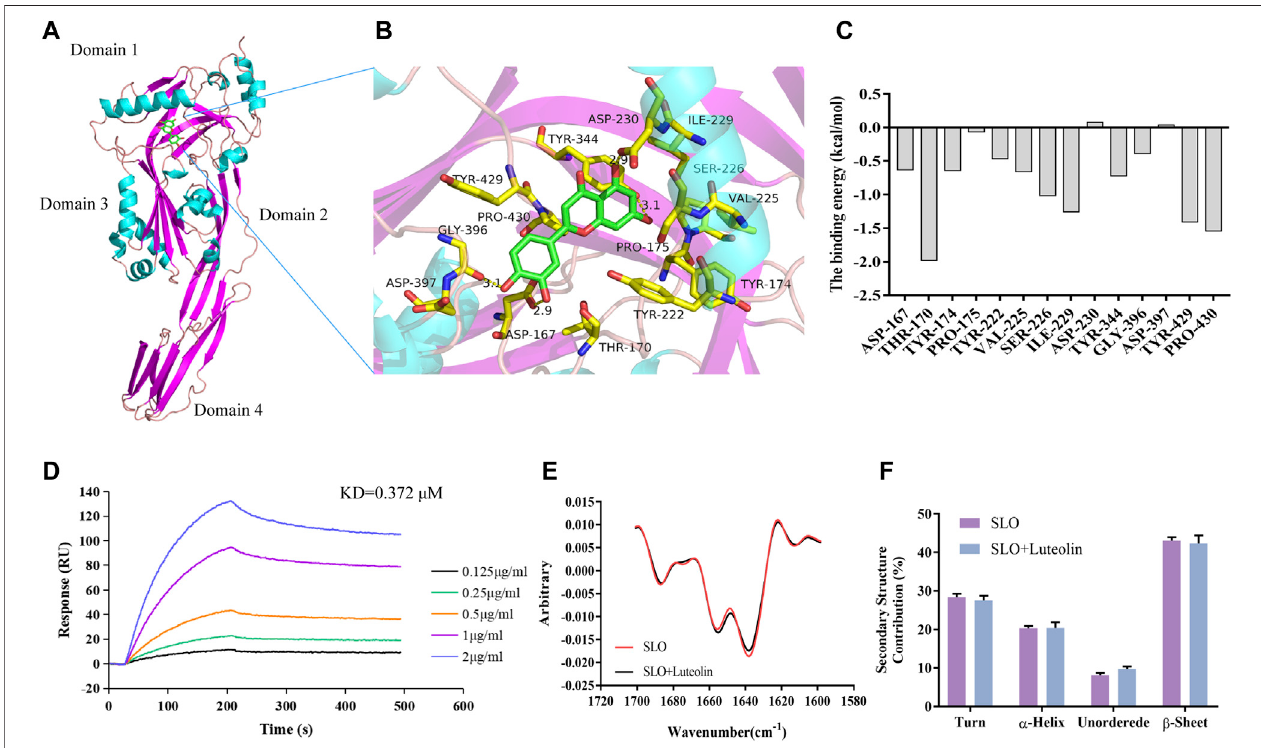
FIGURE 2 | Binding mode of luteolin to SLO. (A) Details of the binding site. Amino acid residues in the binding complex ( B) . (C) Energy contributions of the important residues during the binding process. The binding free energy was calculated using the MM-PBSA method. The residues THR-170, TYR-429 and PRO-430 had high binding energy and were critical forthe binding ofluteolin toSLO. (D) SLO was immobilized on an SPRassay chip and luteolin, at the indicated concentrations, was used to determine the binding activity. (E) MMS measurement of protein and protein-ligand complex. (F) Comparison of the secondary structure composition (%).